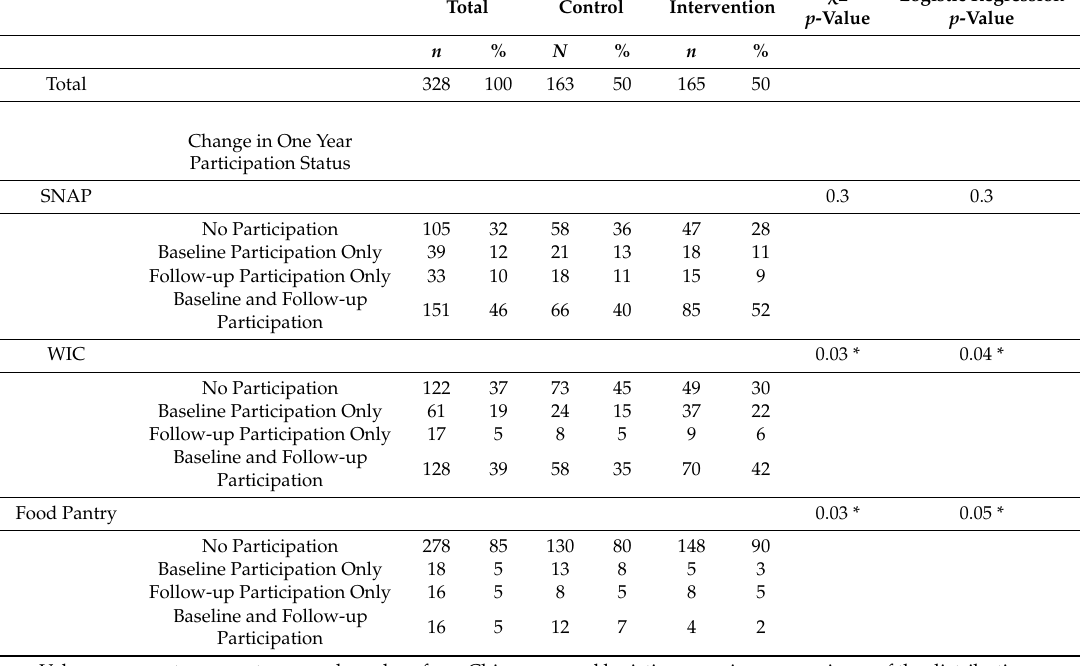
χ 2 Logistic Regression p -Value p -Value